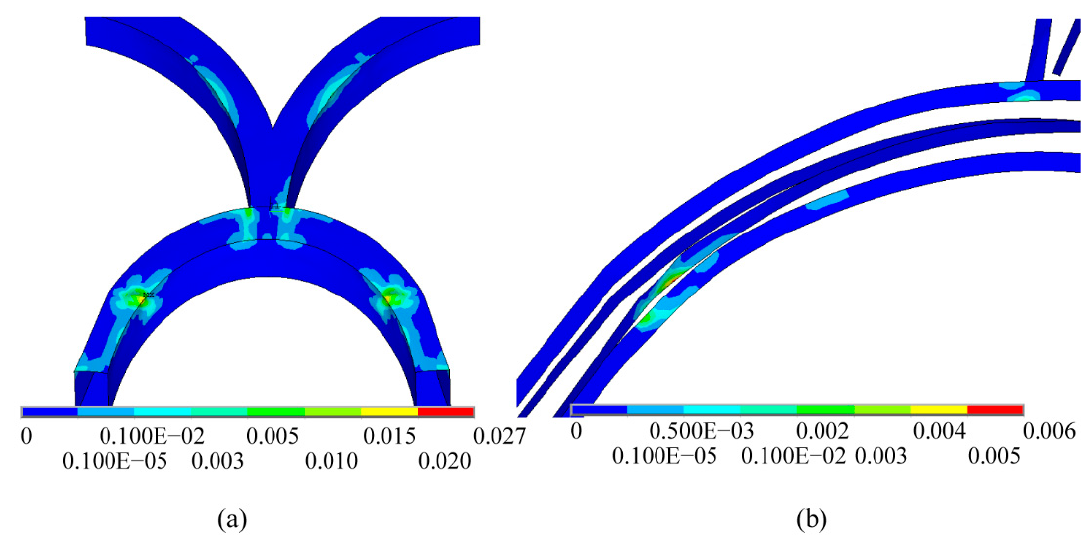
Figure 17. Plastic strain contour plot in the ( a ) web and ( b ) stiffener with T w = 4 mm. When the web thickness of the initial model is changed from 6 mm to 8 mm, the web in the juncture node zone achieves the plastic phase at 3.4 P first. The order of plasticity initialization in other parts is arranged as follows—the diaphragm in the juncture node zone at 3.6 P , the diaphragm in the lower arch at 3.8 P , the longitudinal stiffening rib